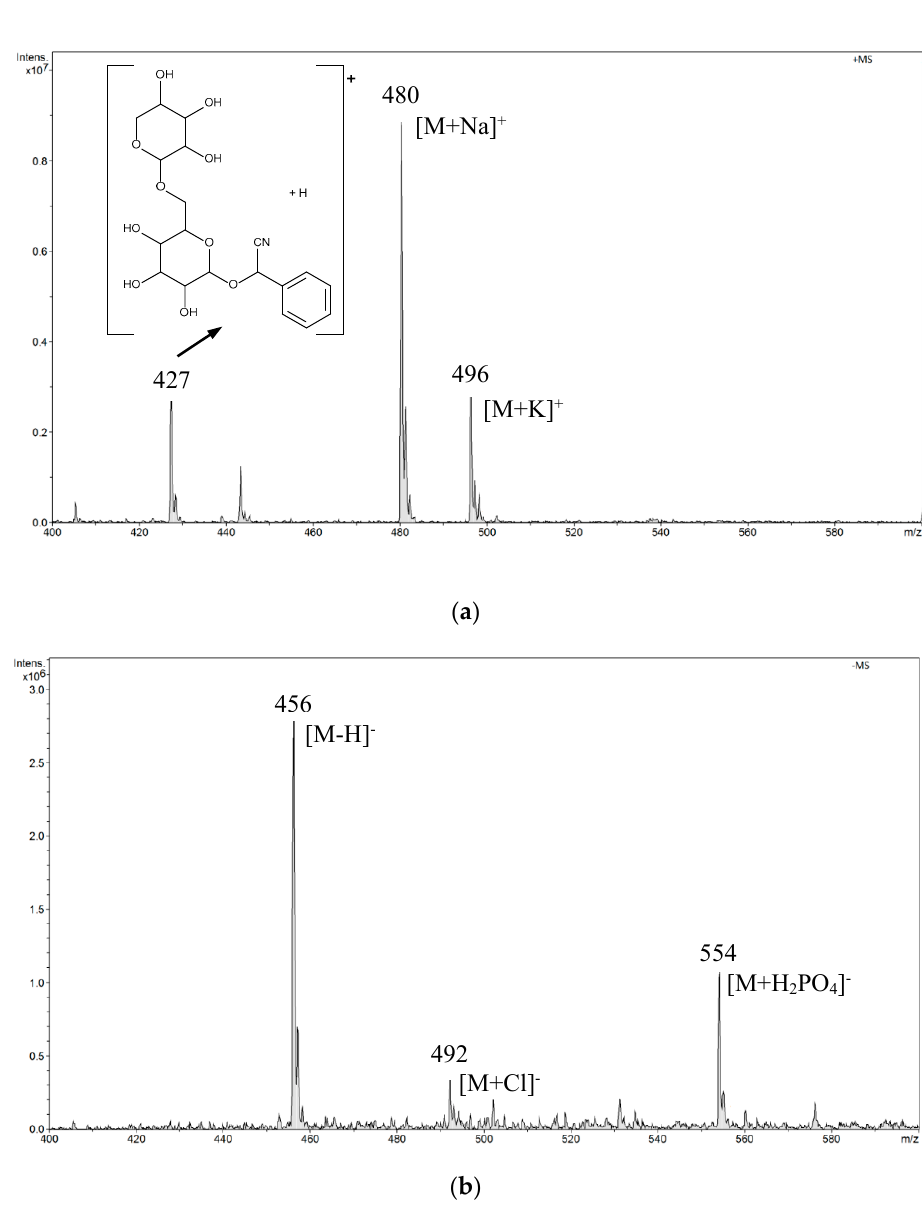
Figure 4. The electrospray ionization mass spectrometry (ESI-MS) spectrum of amygdalin performed in a buffer solution of pH 7.0 (disodium hydrogen phosphate and citric acid): ( a ) positive mode, ( b ) negative mode.